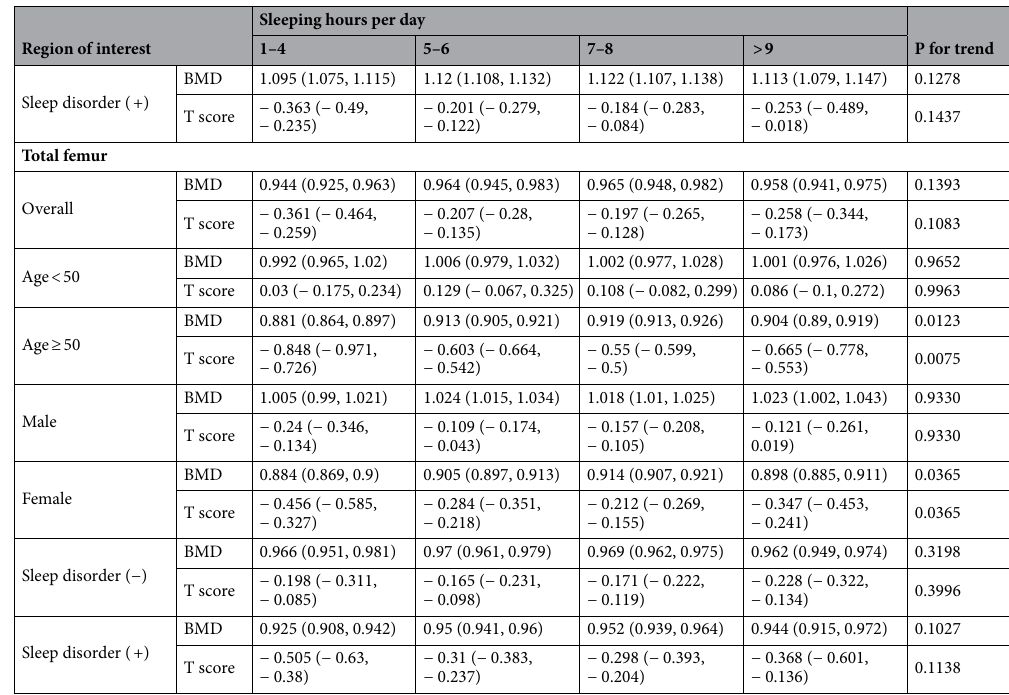
Table 2. BMD (T-score) over femoral neck, trochanteric, intertrochanteric, and total femoral areas in 4 type of sleep duration. Adjust for age, gender, energy, weight, CKD. *There is significant difference P <